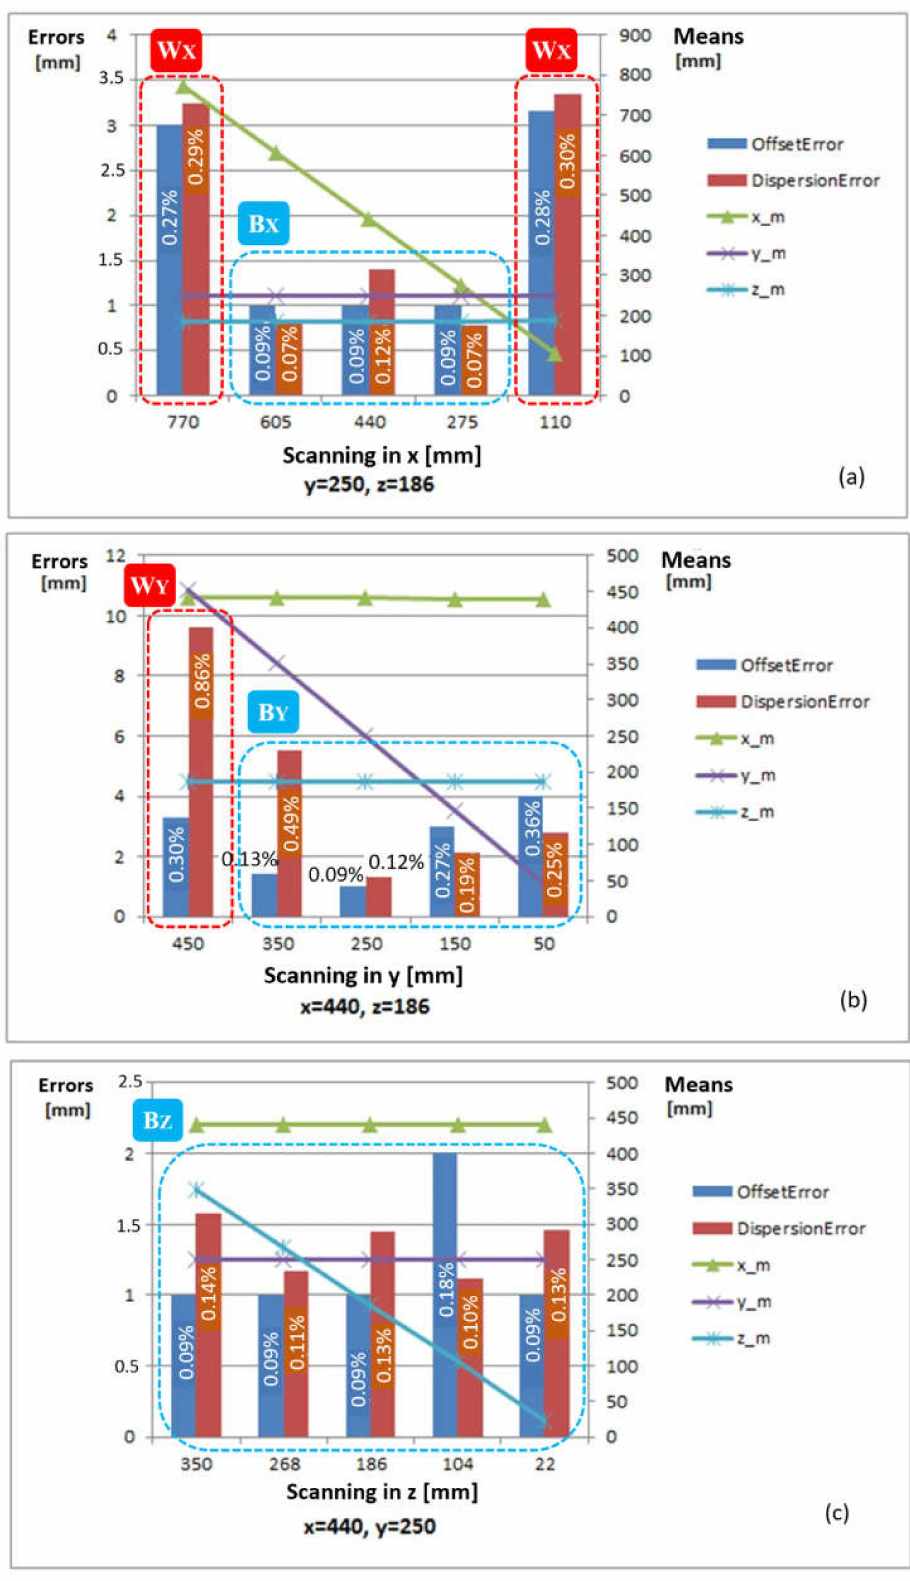
Figure 13. Results (2%) of the scanning X in ( a ), the scanning Y in ( b ) and the scanning Z in ( c ). These results show different axis-dependent zones. The Bk areas are zones with a small limited stable error and the Wk areas are zones in the borders that exhibit